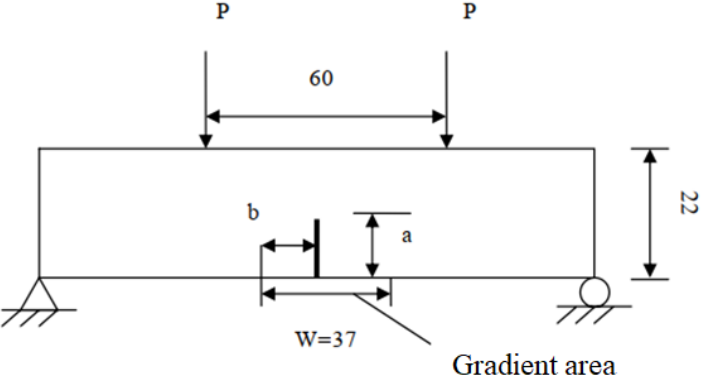
Figure 9. Schematic diagram of the model. Table 2. Material parameter table of the FGM.